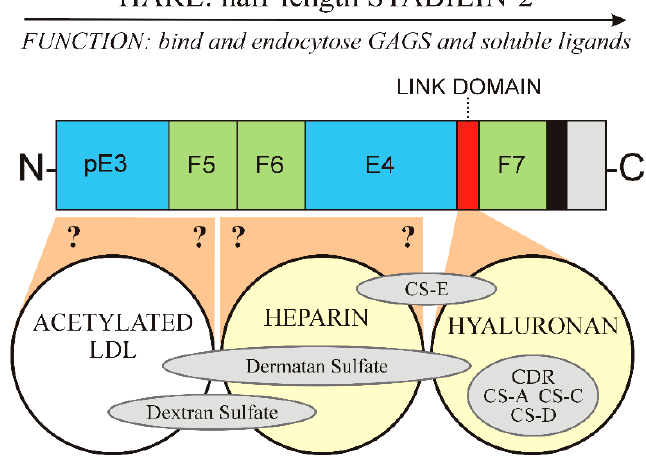
Figure 3. All GAG and other soluble ligand-binding domains are within the HARE portion of Stab2. The half-receptor HARE isoform (1416 aa) is the C-terminal half of Stab2 and contains the CD (gray), membrane (black) and Link (red) domains, as well as Fasciclin-1 domains F5–F57 and EGF-like domain E4 of the full-length protein (Figure 2). The N-terminal region of HARE is a truncated portion of the Stab2 E3 domain (pE3). All known GAG binding sites (yellow circles and gray ellipses) are within HARE [24,25]. The Link module enables binding to HA, CDR, CS-A, CS-C and CS-D (right yellow circle); these four CDR GAGs inhibit HA binding and Link module deletion eliminates all five binding activities [26]. A separate Hep binding site is on the N-terminal side of the Link domain. A third independent binding site for acetylated low-density lipoprotein (AcLDL; white circle), is assigned to the N-terminal side of the Hep site. Based on competition studies [26], DS binds to or occludes the Hep binding site and partially blocks both HA and AcLDL binding. DxS competes with both Hep and AcLDL binding but does not block HA binding. CS-E competes at a low level with both HA and Hep but does not affect AcLDL binding.